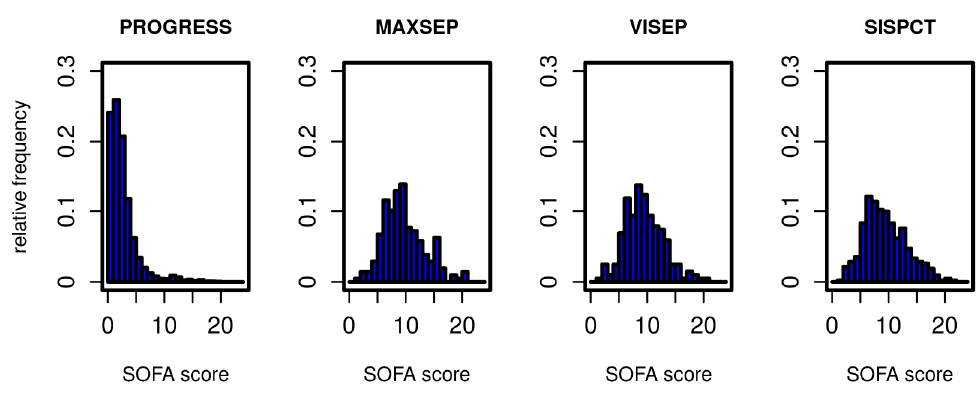
Figure 1. Distribution of SOFA scores for all studies on the first study day. Table 2. Disease states defined by the SOFA score.